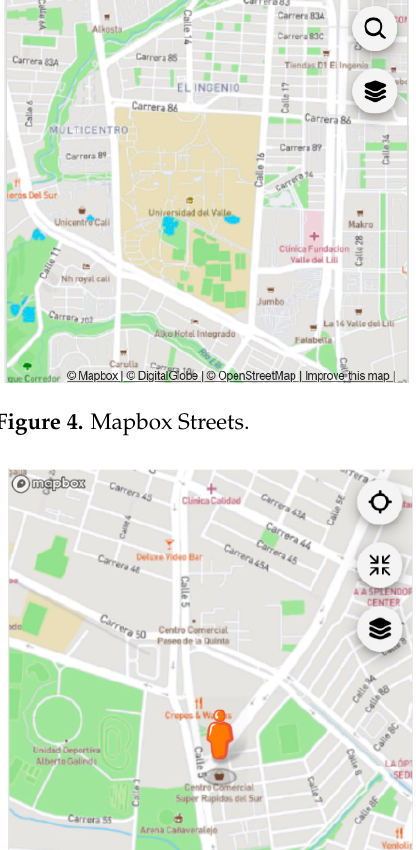
Figure 4. Mapbox Streets.